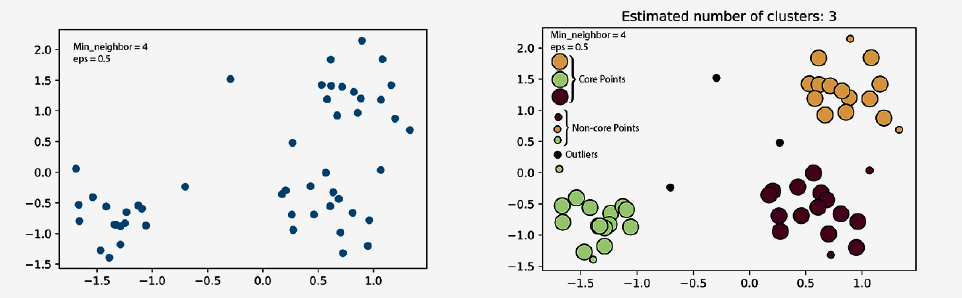
Figure 18. Left : Before Clustering, Right : After DBSCAN